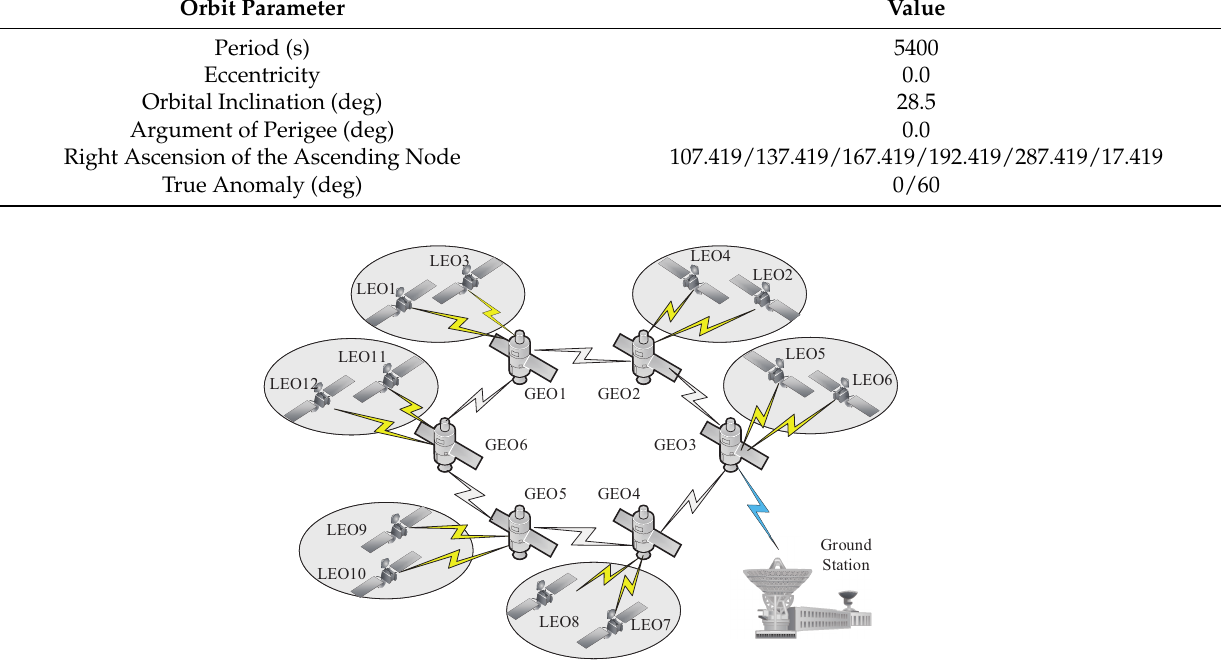
Figure 14. Topology of the IP satellite scenario. Table 7. GEO satellite orbit parameters and corresponding values.